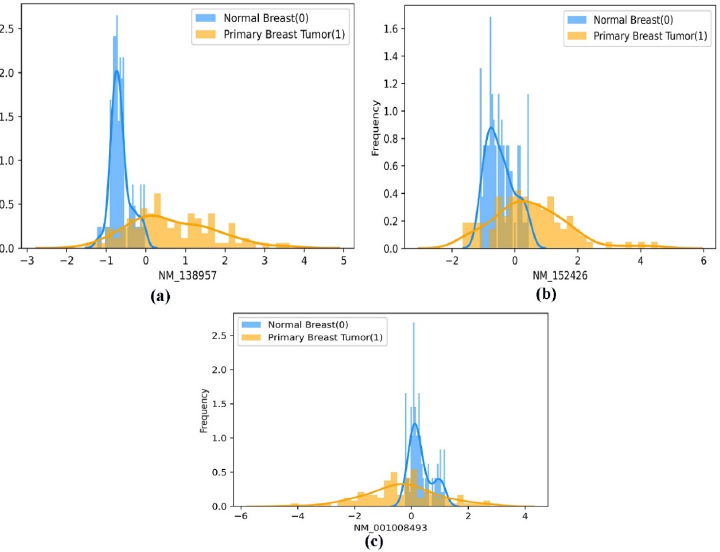
optimal gene biomarkers ( a ) ‘NM_138957’, ( b ) ‘NM_152426’, and ( c ) ‘NM_001008493’, between the two classes of population (normal breast and primary breast tumor